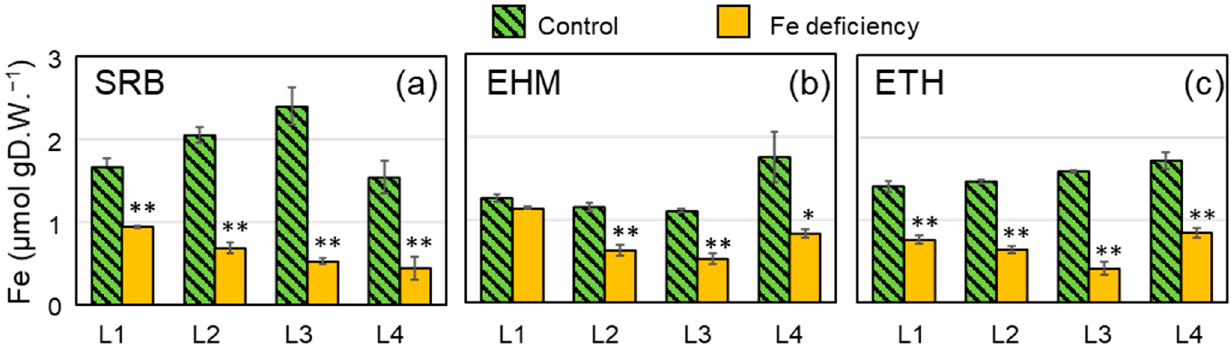
Figure 2. Total Fe concentration in each leaf of seedlings after four days of Fe depletion. Fe contents were evaluated in three barley cultivars grown in hydroponic solutions containing 30 μ M (green) or 0 μ M (orange) EDTA-Fe for four days. ( a ) “Sarab1” (SRB), ( b ) “Ehimehadaka1” (EHM), and ( c ) “Ethiopia 2” (ETH). Values represent the mean (SE) of the three plants. L1 is the oldest leaf and L4 is the premature leaf just emerging. * p < 0.05 and ** p < 0.01 indicate significant differences (according to Student’s t -test) between the control leaf and Fe-deficient leaf.